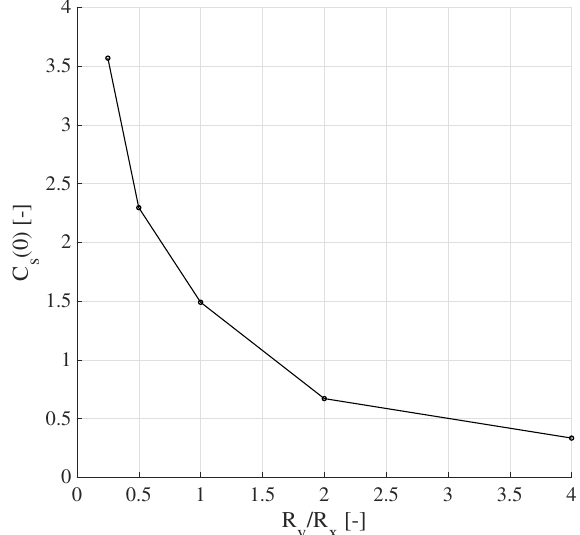
Figure 19. Slamming coefficient at first impact time as a function of aspect